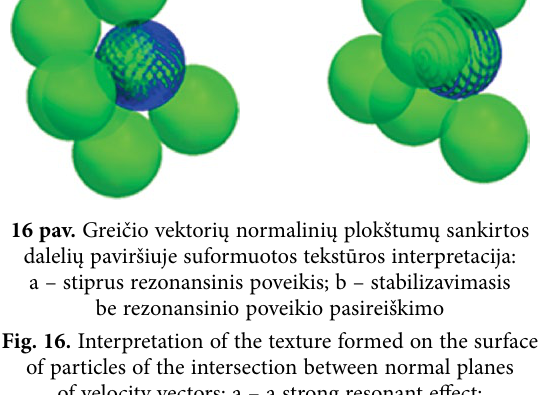
Fig. 16. Interpretation of the texture formed on the surface of particles of the intersection between normal planes of velocity vectors: a – a strong resonant